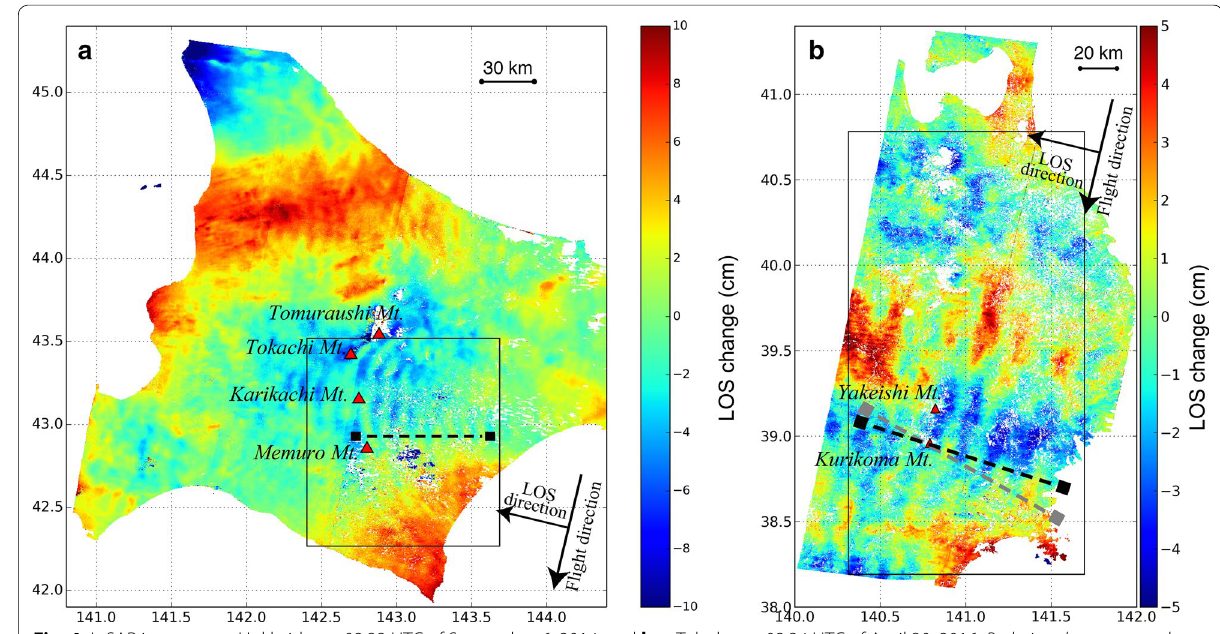
Fig. 4 InSAR images a at Hokkaido on 02:33 UTC of September 6, 2014, and b at Tohoku on 02:34 UTC of April 30, 2016. Red triangles represent loca- tions of the mountain top. Warmer color indicates areas where much water vapor exists relative to the surrounding and cooler color is areas of less water vapor. Black-lined regions indicate areas in Fig. 7. A dashed black line in a indicates the profile in Figs. 6a, 8 and 10. Dashed black and gray lines in b indicate profiles of observed and simulated delays, respectively, in Fig. 9. The dashed black line in b also indicates the profile in Fig.